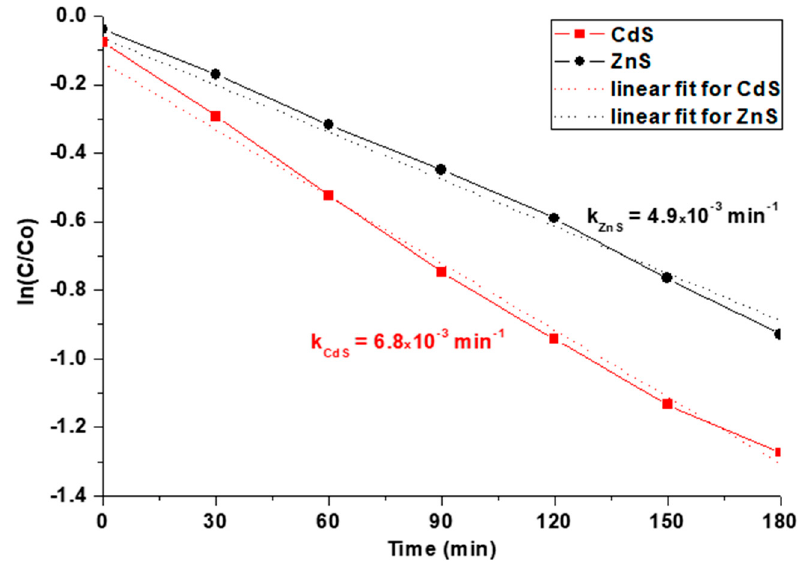
Figure 6. Linear fit of ln(C/C o ) as a function of time for the first-order reaction with respect to MB.